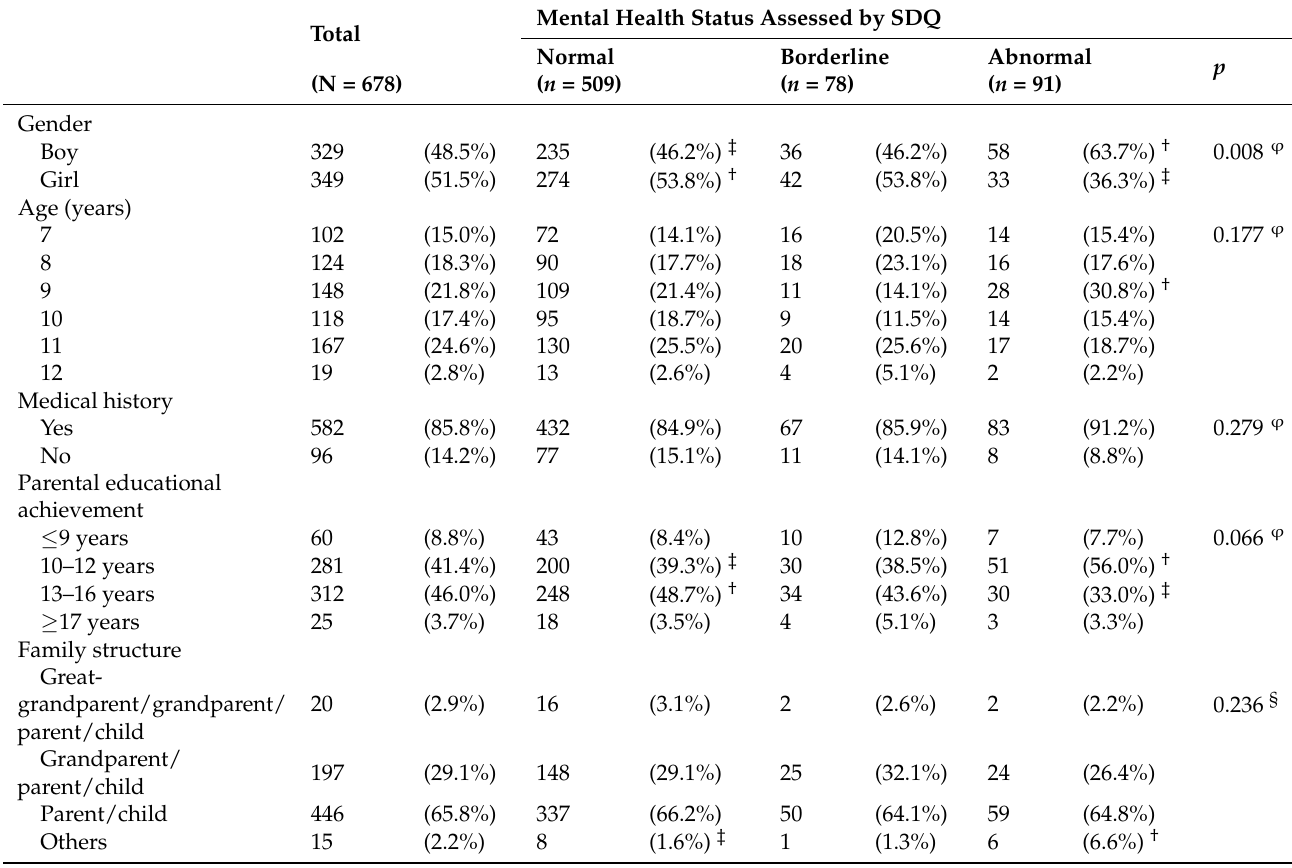
Table 1. Characteristics of Japanese elementary schoolchildren according to classification of mental health status assessed by the Strengths and Difficulties Questionnaire (N =